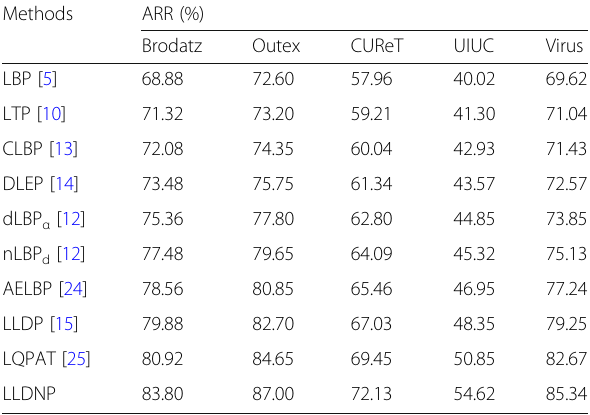
Table 6 Results of various methods in terms of ARR on five databases